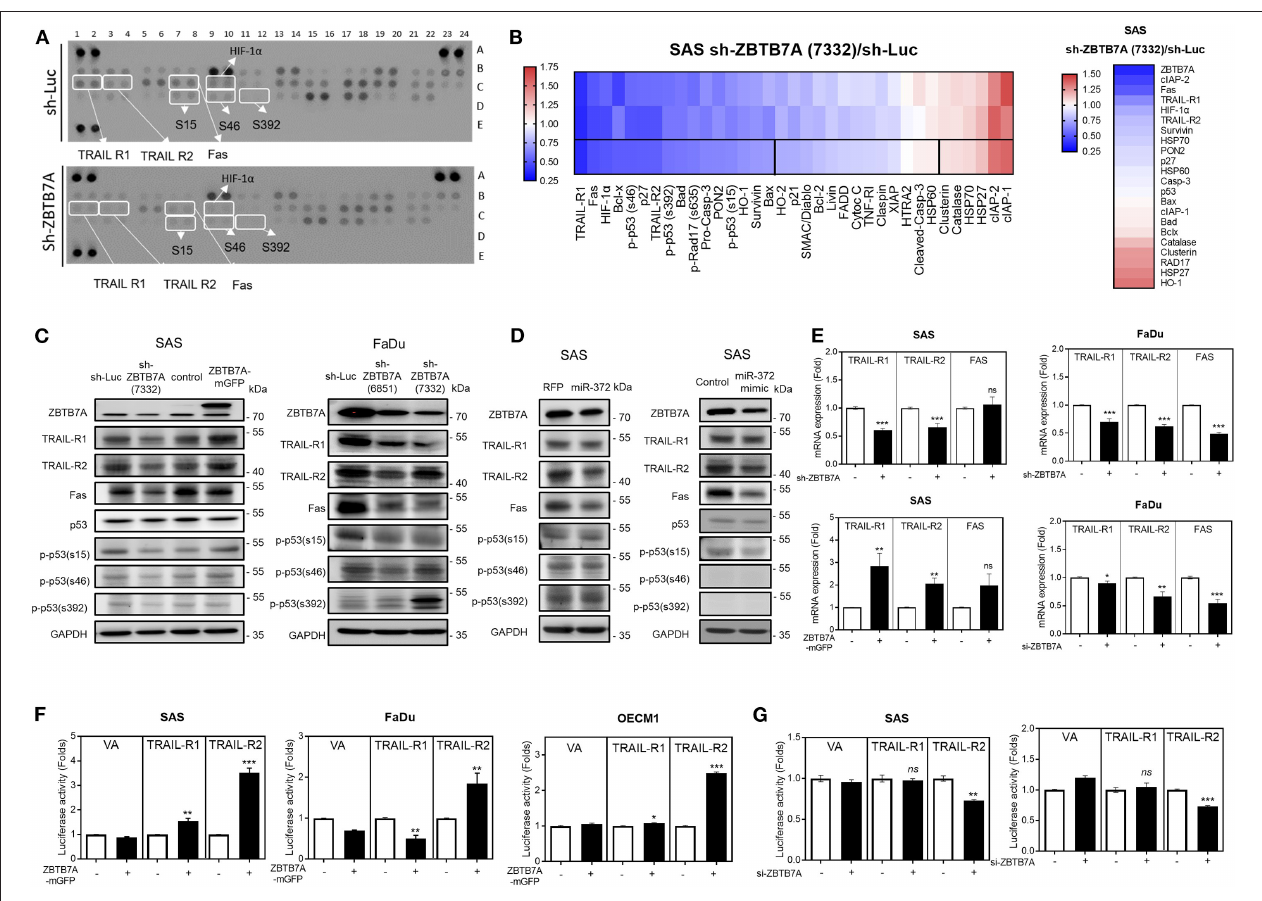
FIGURE 4 | ZBTB7A expression is associated with the expression of death receptors and the phosphorylated isoforms of p53 in OSCC cells. (A,B,D) SAS cells. (A) Apoptosis array. A panel of 35 antibodies including various forms of phosphorylated p53 were measured in duplicate using this array. The ZBTB7A knockdown cell subclone and the control cells were treated with CDDP for 24h, and then the array was used to identify changes in various apoptosis factors. Lt, a diagram of the array. White rectangles indicate duplicates exhibiting significant changes in signal following ZBTB7A knockdown. Rt, a heat-map demonstrating the changes in protein profile following ZBTB7A knockdown. The 3rd lane represents the average value of the duplicate signals in the upper two lanes. Vertical lines define the 20 proteins that are downregulated > 30% (Lt region) or that are upregulated > 12% (Rt region). (B) RNA sequencing. A heat-map showing the changes in transcript levels in the ZBTB7A subclone. The genes selected for analysis are TRAIL-R1, TRAIL-R2, Fas and the various phosphorylated isoforms of p53 and many of these were downregulated following knockdown of ZBTB7A; thus these are to be considered as ZBTB7A targets during apoptosis modulation. (C,D) Western blot analysis. (C) Lt, SAS cells, Rt, FaDu cells. Expression of TRAIL-R1, TRAIL-R2, Fas, and p53 phosphorylated at serine 15 is correlated with ZBTB7A expression (in C ), and is inversely correlated with ZBTB7A knockdown (in C ) and miR-372 expression (in D ) in OSCC cells. (E) qRT-PCR analysis. This shows the concordant changes in TRAIL-R1 and TRAIL-R2 mRNA expression in OSCC cells following ZBTB7A knockdown/expression. (F,G) Promoter activity assay. This shows the consistent increase and decrease in TRAIL-R2 activity that follows expression and transient knockdown of ZBTB7A in OSCC cells, respectively. ns , not significant; * p < 0.05; ** p < 0.01; *** p <